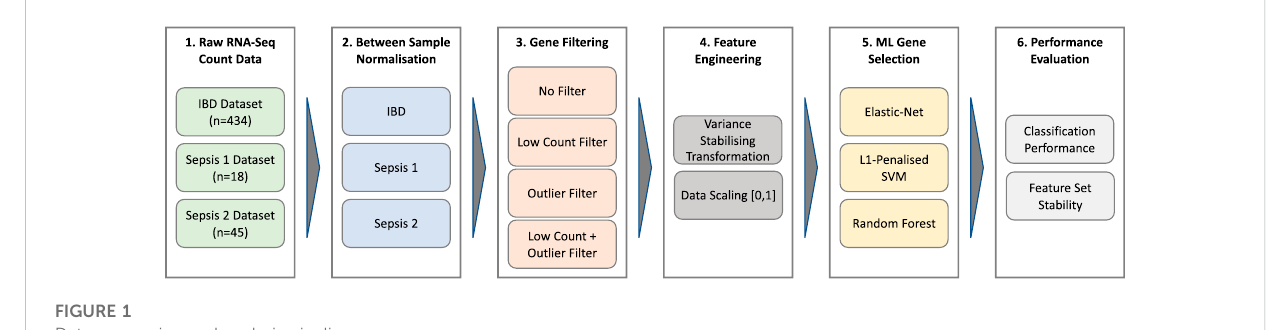
FIGURE 1 Data processing and analysis